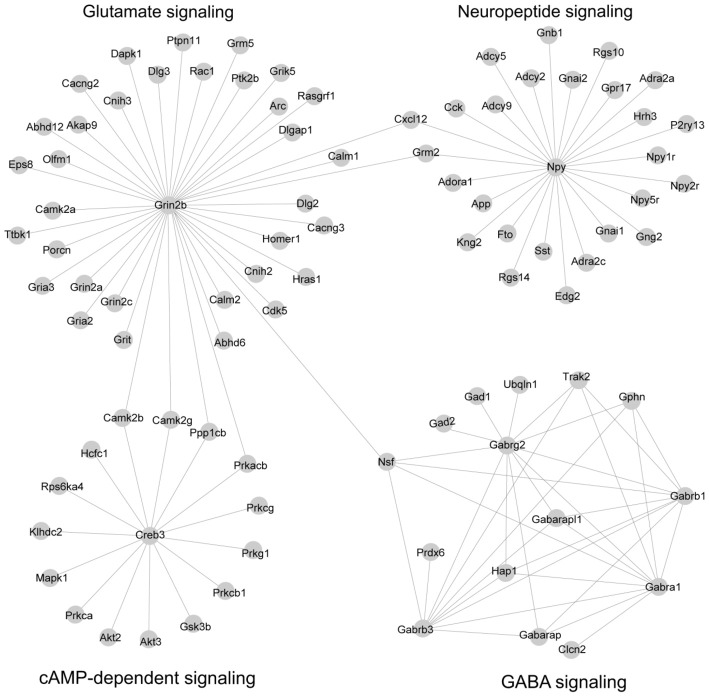
Subnetworks were constructed by combining co-expression network and protein-protein interaction (PPI) network. A total of 14 co-expression modules identified by co-expression analysis were superposed with PPI networks from the STRING database, leading to four subnetworks. The network was visualized by Cytoscape software.